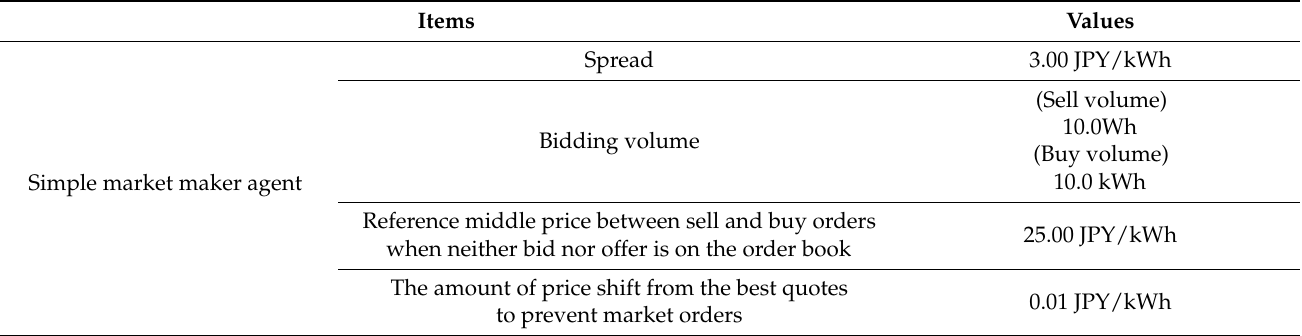
Table 5. Initial parameters in P2P electricity market simulation with the simple market maker.